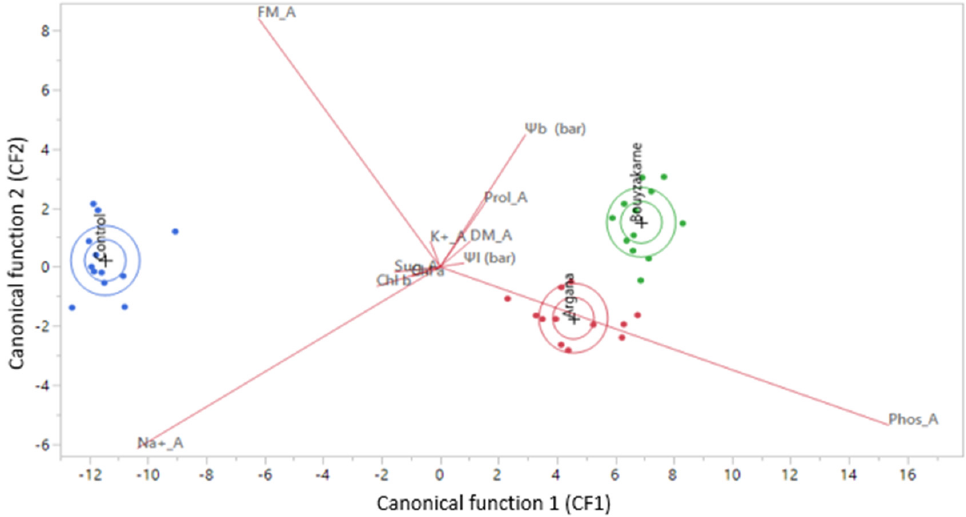
Figure 8. Two-dimensional point cloud showing the separation of the inoculum studied according to the two gradients of the discriminant functions obtained by CDA for the parameters recorded in the aerial part (FM_A: aerial fresh matter, DM_A: aerial dry matter, Sug_A: aerial sugar, Prol_A: aerial proline, Phos_A: aerial phosphorus).